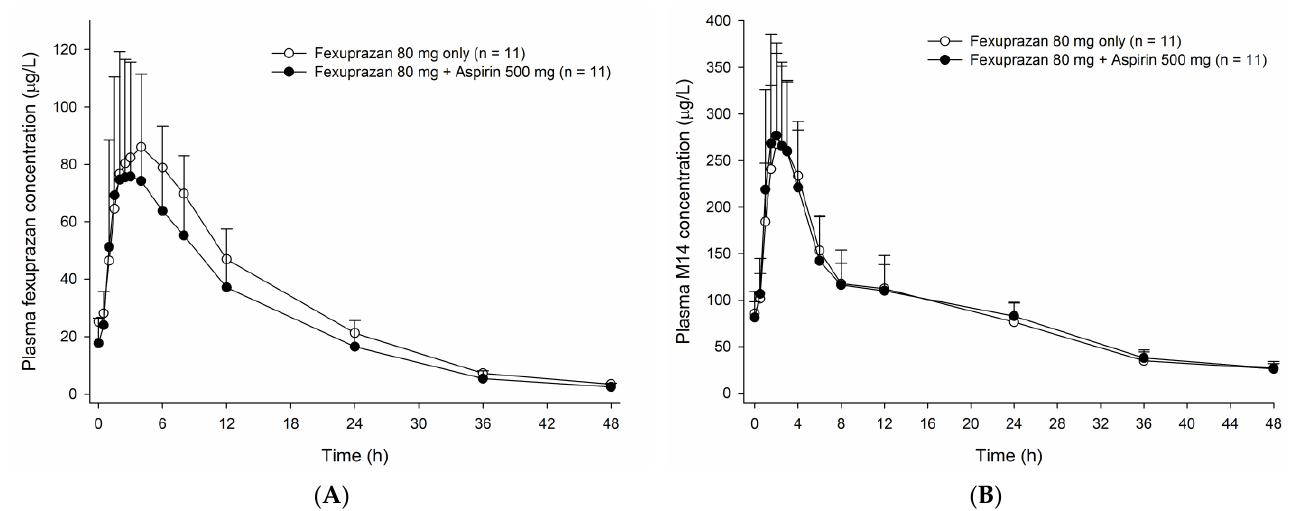
Figure 4. Mean plasma concentration-time profiles of ( A ) fexuprazan and ( B ) M14 measured after multiple oral administrations of fexuprazan 80 mg alone and coadministered with aspirin 500 mg. The error bars represent the standard deviations. Table 2. Pharmacokinetic parameters of fexuprazan determined after multiple oral administrations of fexuprazan 80 mg alone and coadministered with aspirin 500 mg.